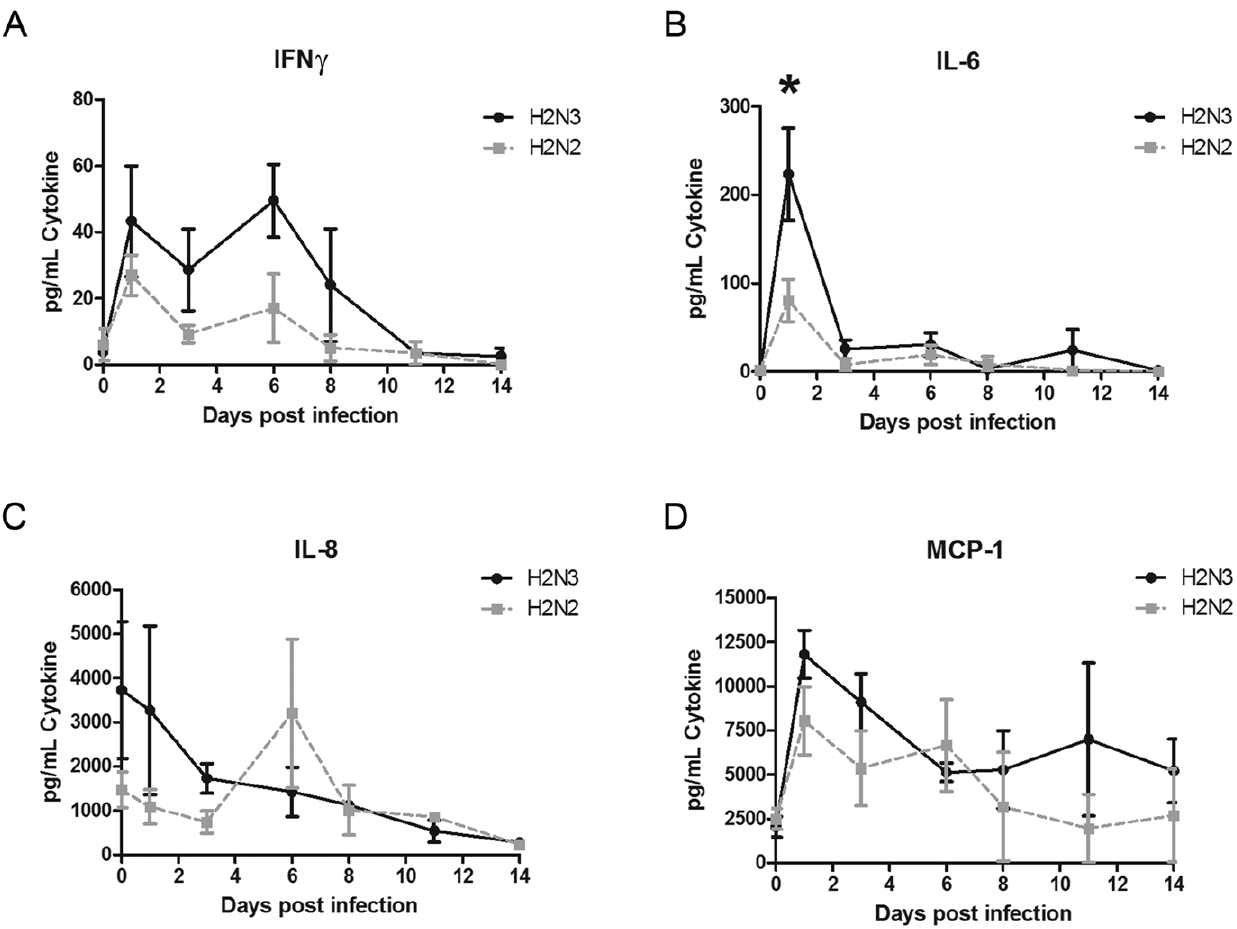
Figure 5. Plasma cytokine response in Cynomolgus macaques. Cytokine plasma levels were analyzed by a bioplex assay. (A) Interferon (IFN) c , (B) Interleukin 6 (IL-6), (C) IL-8, and (D) Monocyte chemotactic protein 1 (MCP-1). Error bars represent the standard error of mean from 6 (1 dpi), 4 (3 dpi and 6 dpi) and 2 (8 dpi and 10 dpi) animals. *significant difference between H2N3 and H2N2 infected animals by t-test; p , 0.05).